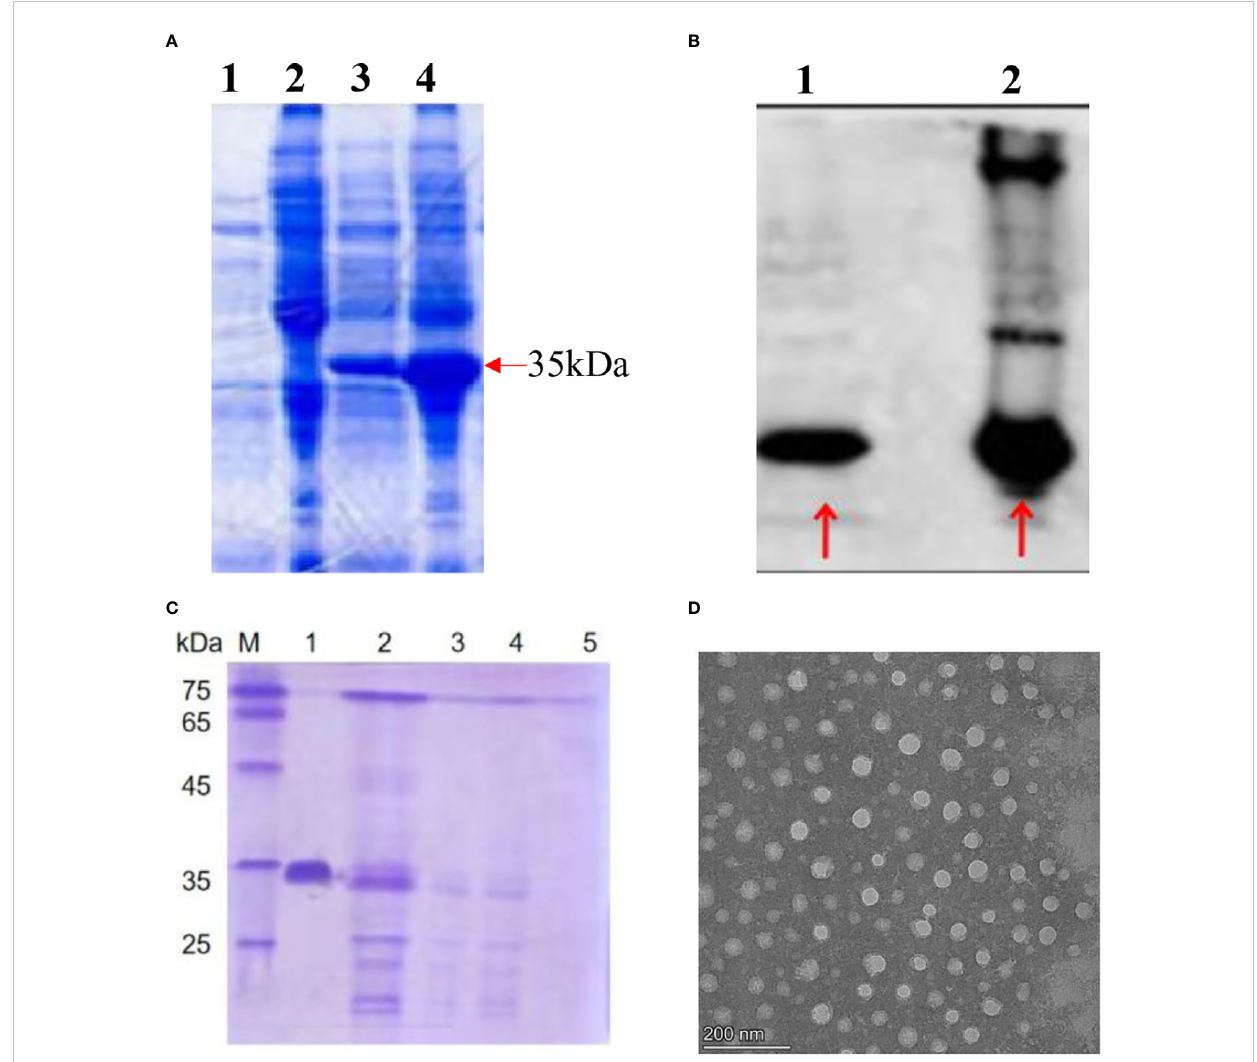
FIGURE 1 Production and morphology of the HBc-GE11 VLPs. (A, B) SDS-PAGE and Western blot analysis of HBc-GE11 protein expression. (A) Lines 1 and 2, bacterial lysate precipitation and supernatant before induction; lines 3 and 4, bacterial lysate precipitation and supernatant after induction. (B) Line 1, bacterial lysate precipitation after induction; line 2, bacterial lysate supernatant after induction. (C) Representative protein normalized SDS-PAGE of F1 – F5. (D) Representative transmission electron micrographs of HBc-GE11